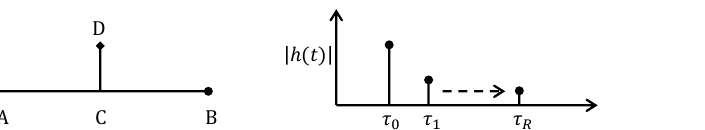
Figure 2. CIR of the link between two given communicating devices, A and B, in a T network with a termination point D.